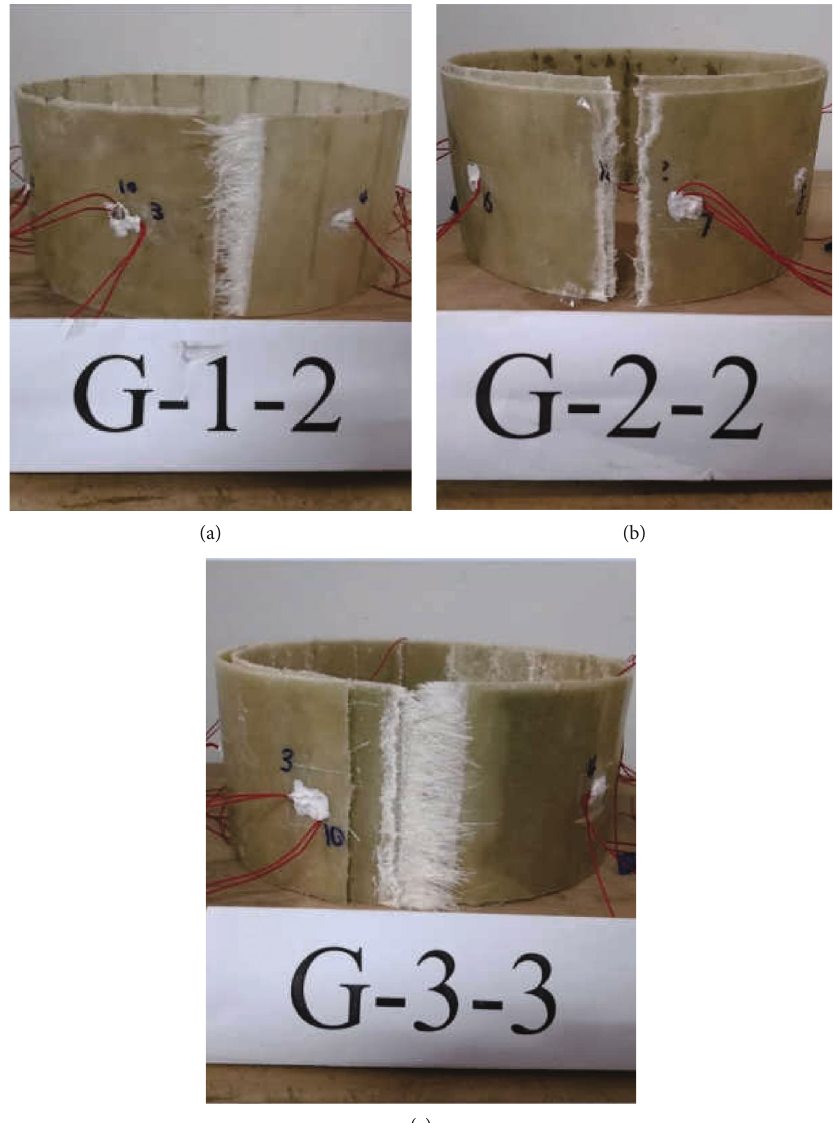
Figure 12: Failure modes of the test group without rubber